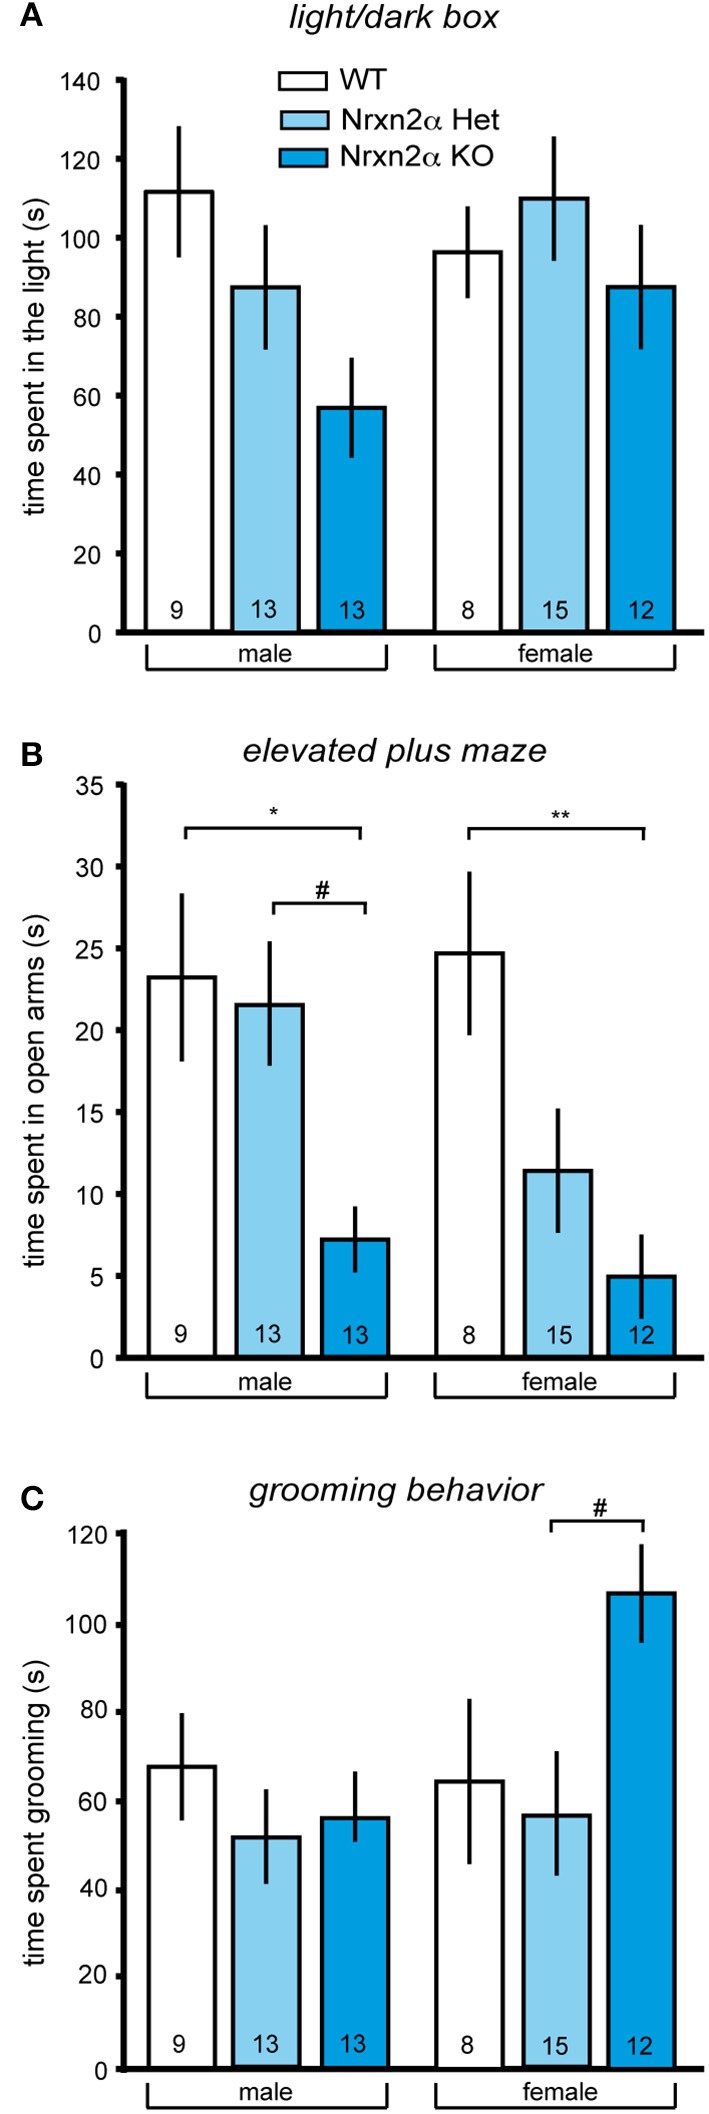
Increased anxiety-like and repetitive behaviors in Nrxn2α-deficient mice. Anxiety behavior of Nrxn2α KO was assessed in the light/dark box and the elevated plus maze. (A) Time (s) spent in the light compartment of the light/dark box male (left pair of bars) and female mice (right pair of bars), respectively. (B) Time (s) spent in the open arms of the elevated plus maze by male (left pair of bars) and female (right pair of bars) mice, respectively. (C) Time (s) spent in grooming was quantitated to analyze repetitive behaviors of male (left pair of bars) and female mice (right pair of bars). Data shown are mean (± SEM) and derived from 17 WT (white bars, 9♂, 8♀), 28 HET (light blue bars, 13♂, 15♀), and 25 Nrxn2α KO mice (blue squares, 13♂, 12♀); level of significance indicated by *p < 0.05 and **p < 0.01, compared to WT and #p < 0.05, compared to HET.